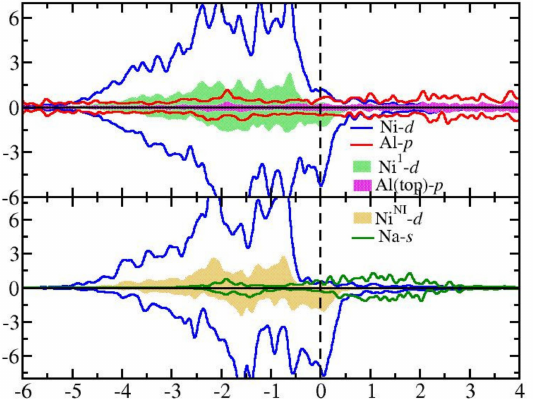
Figure 2. The upper panel presents the DOS plot for the Al intercalated system. Blue—the sum of all d states of Ni for all configurations. The red line is the sum of all p states of Al in Ni/Al. Light green shading—one of the Ni atoms interacting directly with Al top , pink—Al top interacting with the C (hydrogenated) of graphone. The lower panel presents the DOS plot for the Na intercalated system. Blue—the sum of d states of Ni in Ni/Na and the shaded region in yellow is the sum of all Ni-d states for the non-interacting surface Ni atom with Na. Green—s states of